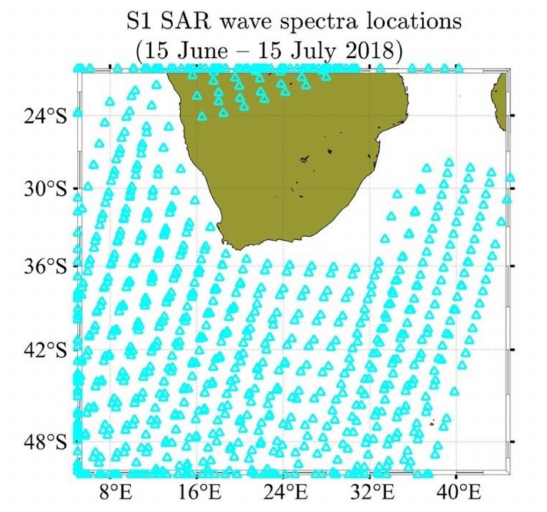
Figure 8. Distribution of the Sentinel 1 (S1) SAR wave mode